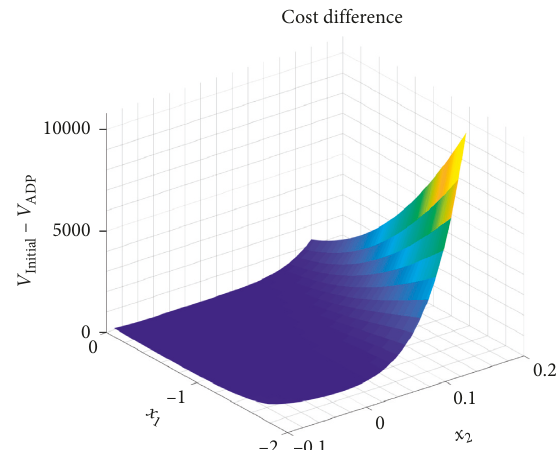
Figure 6: Cost difference between initial admissible control and approximated optimal control.